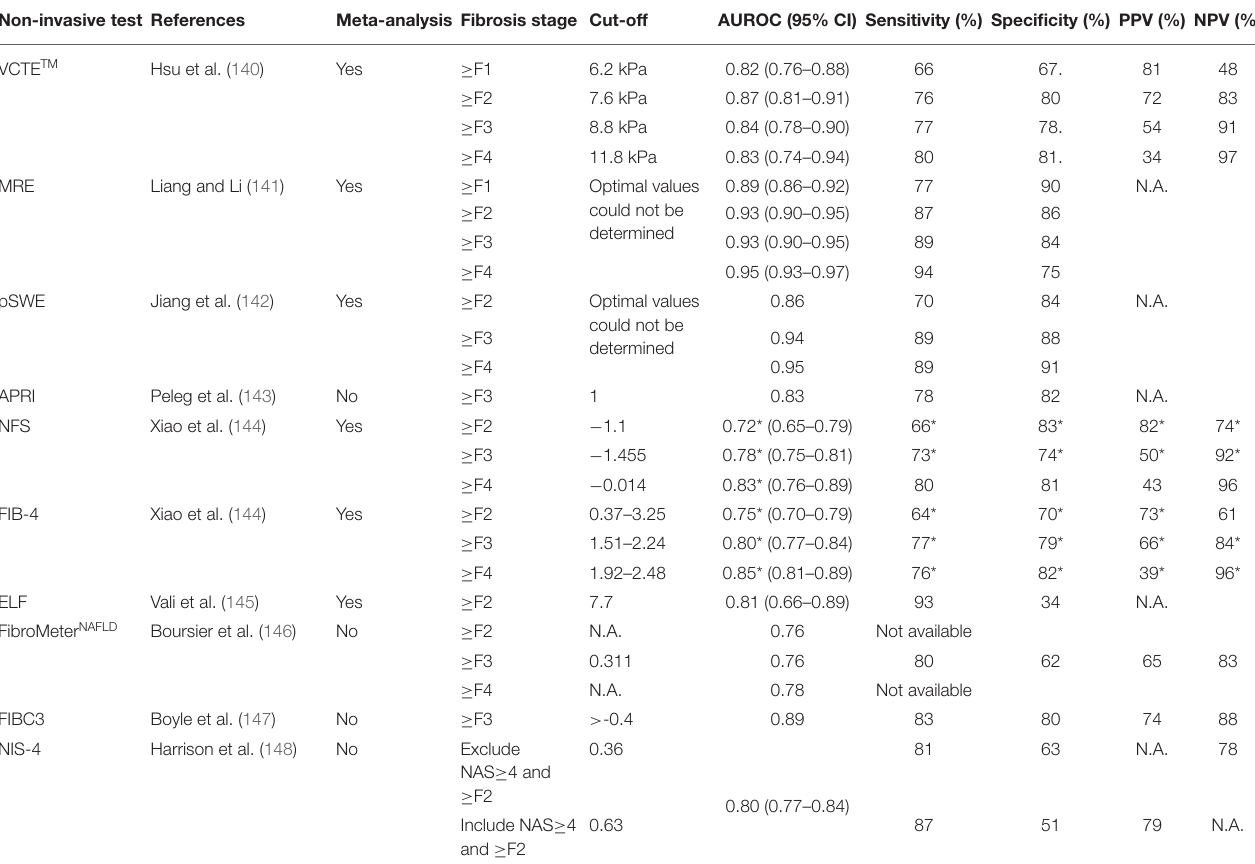
TABLE 2 | Overview of the accuracy indices of the different non-invasive diagnostic tools for NAFLD-related liver fibrosis. Non-invasive test